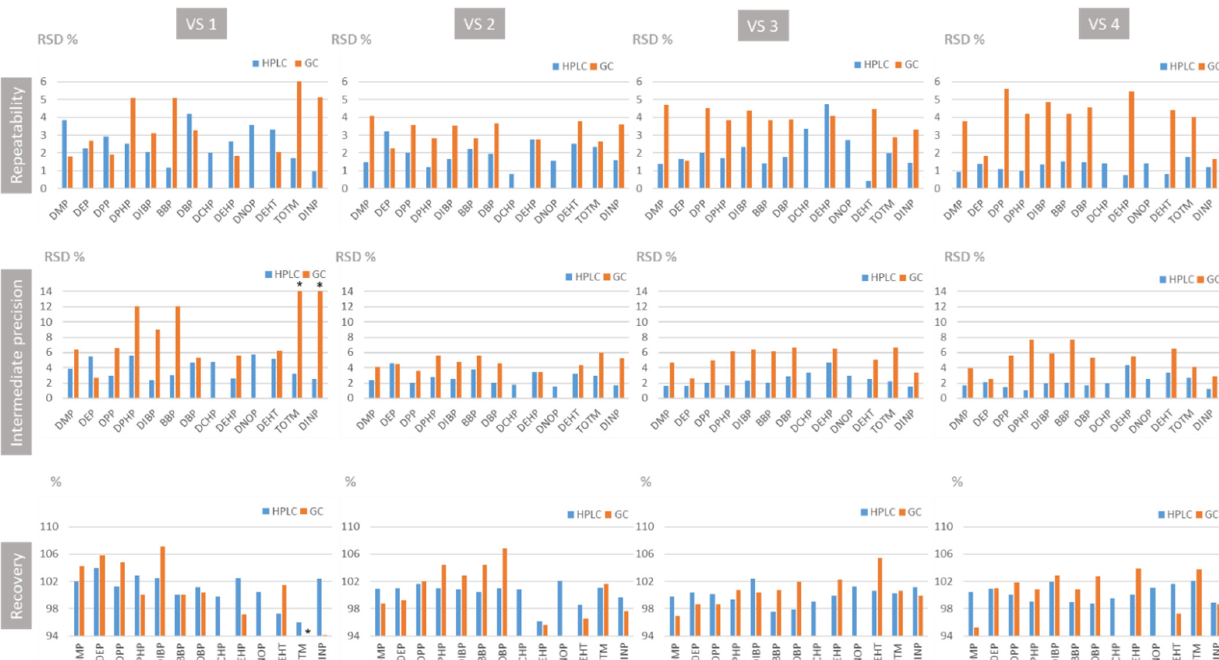
Figure 2. Repeatability, intermediate precision and recovery results of the GC–MS and HPLC–DAD method validation for the analysis of plasticizers. * RSD of intermediate precision and recovery were not in accordance with the acceptance criteria. Table 3. Validation parameters (response function, linearity, and LLOQ) for the analysis of plasticizers by GC–MS and HPLC–DAD.